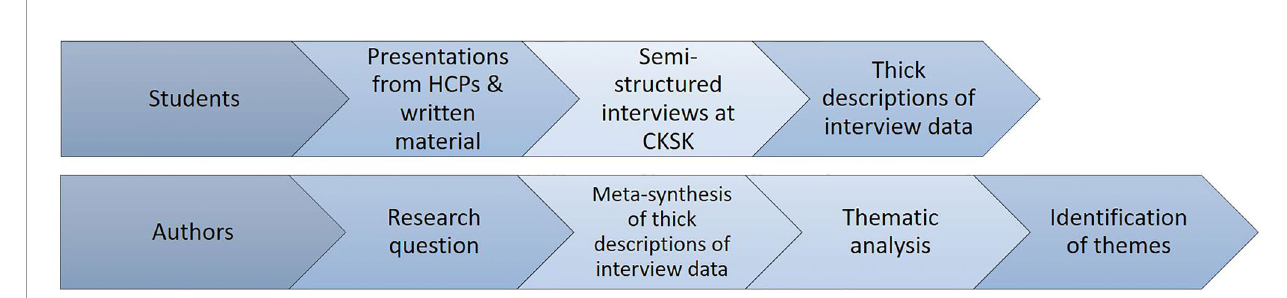
FIGURE 3 | Overview of the data analysis process from the perspectives of the students